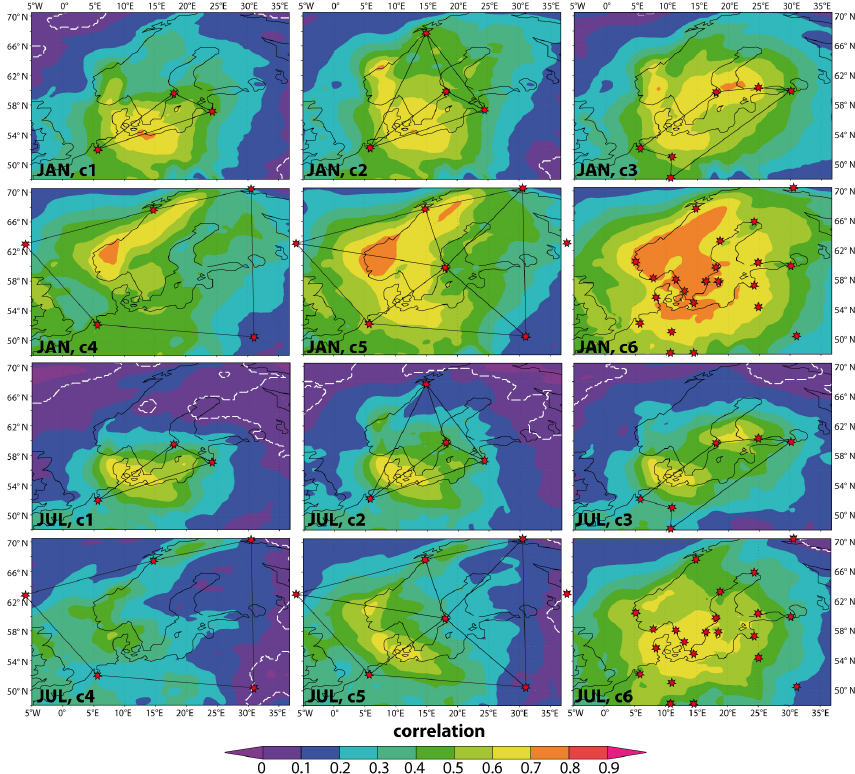
Fig. 5. Correlation of daily wind speeds between a surrogate reconstruction and reference fields of RCAO (RCAX for T2M) for January and July 1958–2007 dependent on the number and distribution of SLP predictors. White shaded lines indicate areas where h 0 of zero correlation cannot be rejected with p <